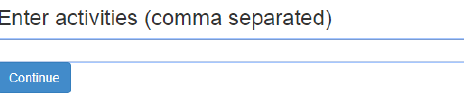
Figure 2. The initial layout of the graphical user interface.